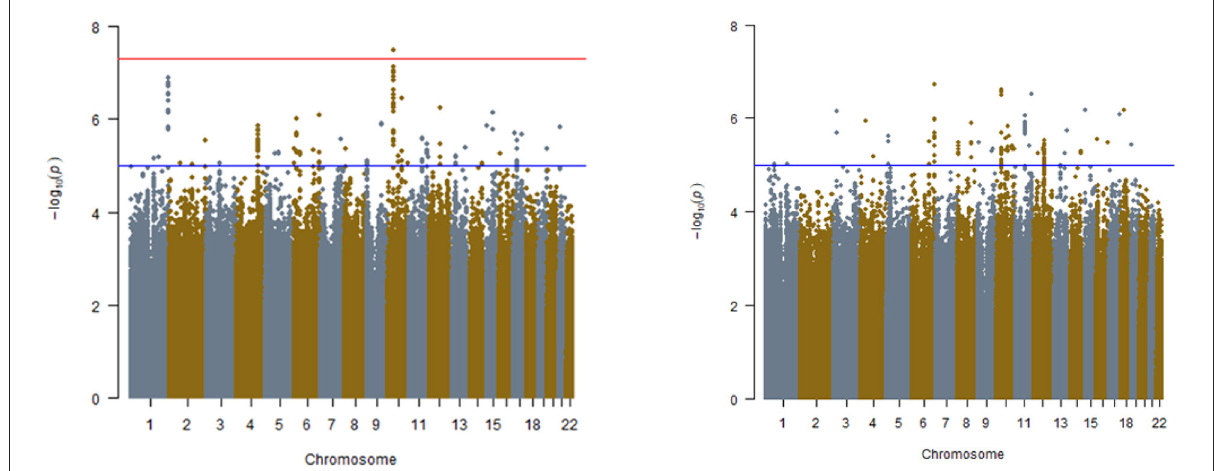
FIGURE1 Manhattan plots for interaction analyses in REGARDS study. (Left) APOL1 risk status determined by additive model, (Right) APOL1 risk status determined by recessive model. Models include APOL1 , SNP, APOL1 *SNP, age, sex, and ancestry. The red line is indicative of genome-wide significance p ≤ 5.00 × 10 − 08 . Blue line is indicative of suggestive significance, p ≤ 1.00 × 10 − 05